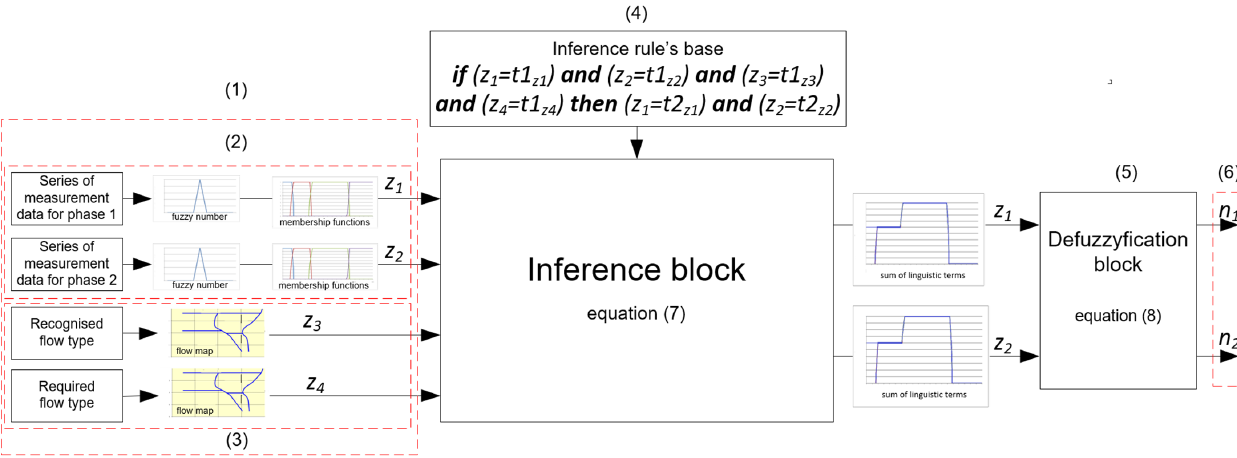
Figure 2. The schema of the fuzzy regulator, where: z 1 , z 2 —SG, SC, z 3 , z 4 —fC, FG, n 1 , n 2 —NSG, NSC. The regulator consists of: